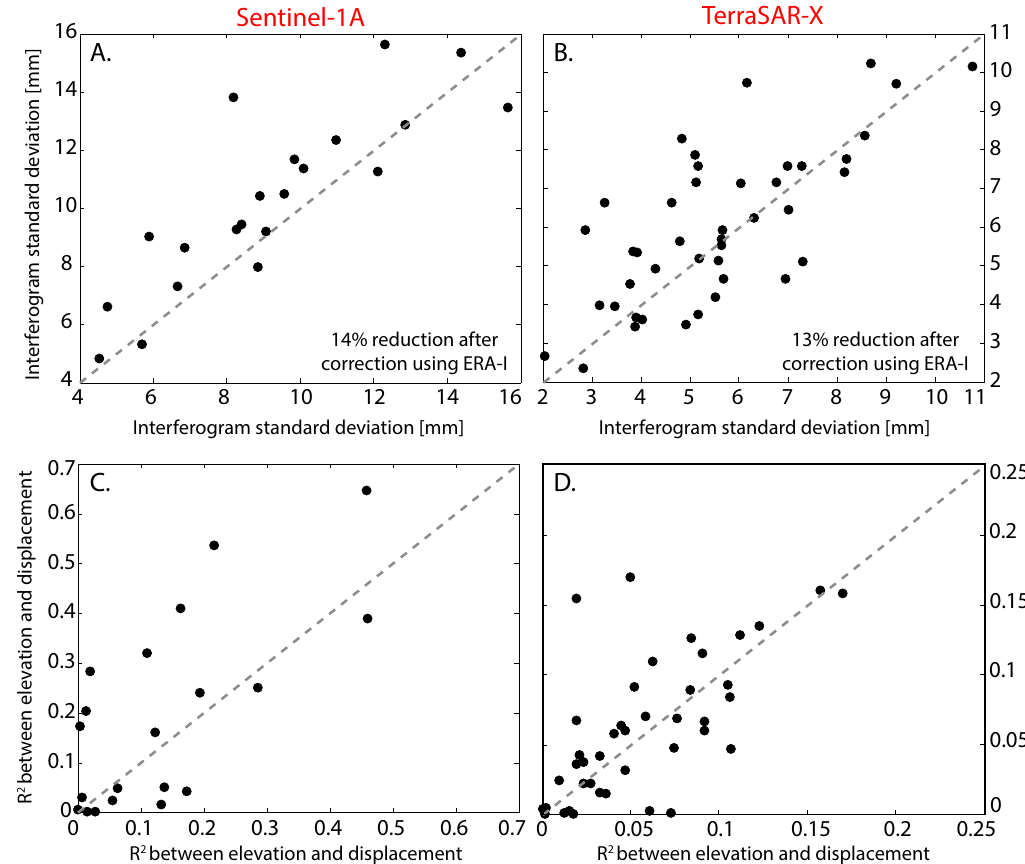
Figure 3. Results of two tests used to evaluate the effect of using ERA-I to correct topographically-correlated atmospheric errors in the InSAR datasets. Interferograms corrected using ERA-I and with an orbital ramp removed are on the x-axes. Interferograms with an orbital ramp removed only are on the y-axes. Each point corresponds to an interferogram, and the dashed line is a 1:1 correlation. ( A , B ) Interferogram standard deviation (mm); ( C , D ) R 2 metric of the correlation between interferogram pixel elevation and displacement. A reduction in value indicates an improvement to the